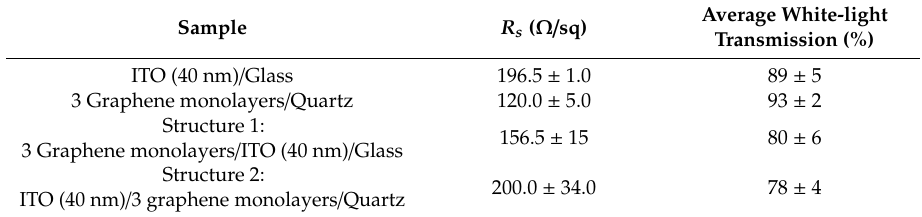
Table 3. Sheet resistance R s and average white-light transmission for the structures in the study where the graphene trilayer is located in di ff erent positions. The optoelectronic data of the indium tin oxide (ITO) thin film and the graphene trilayer transferred on quartz are included for